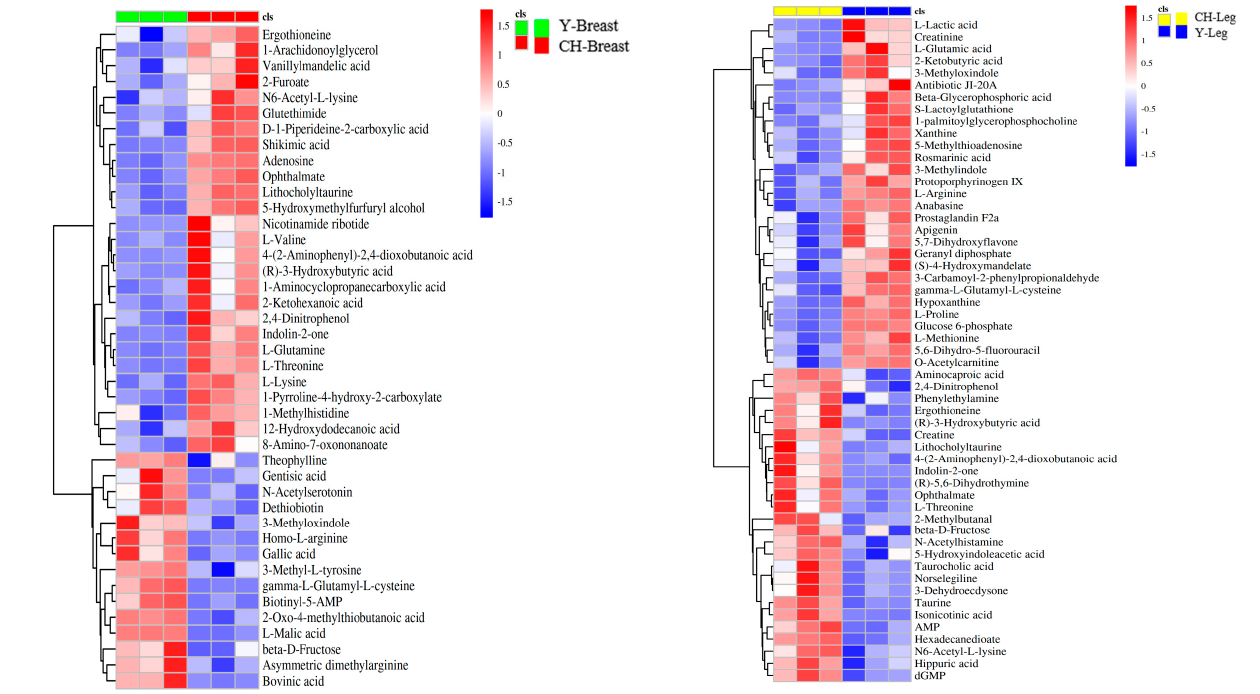
Figure 5. Thermogram of different metabolites in muscle tissue.